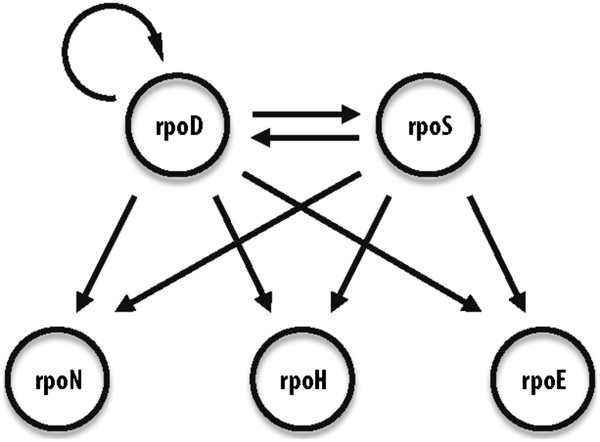
Interaction network of the five sigma factors in K. pneumoniae based on RpoD and RpoS chIP-chip binding data.